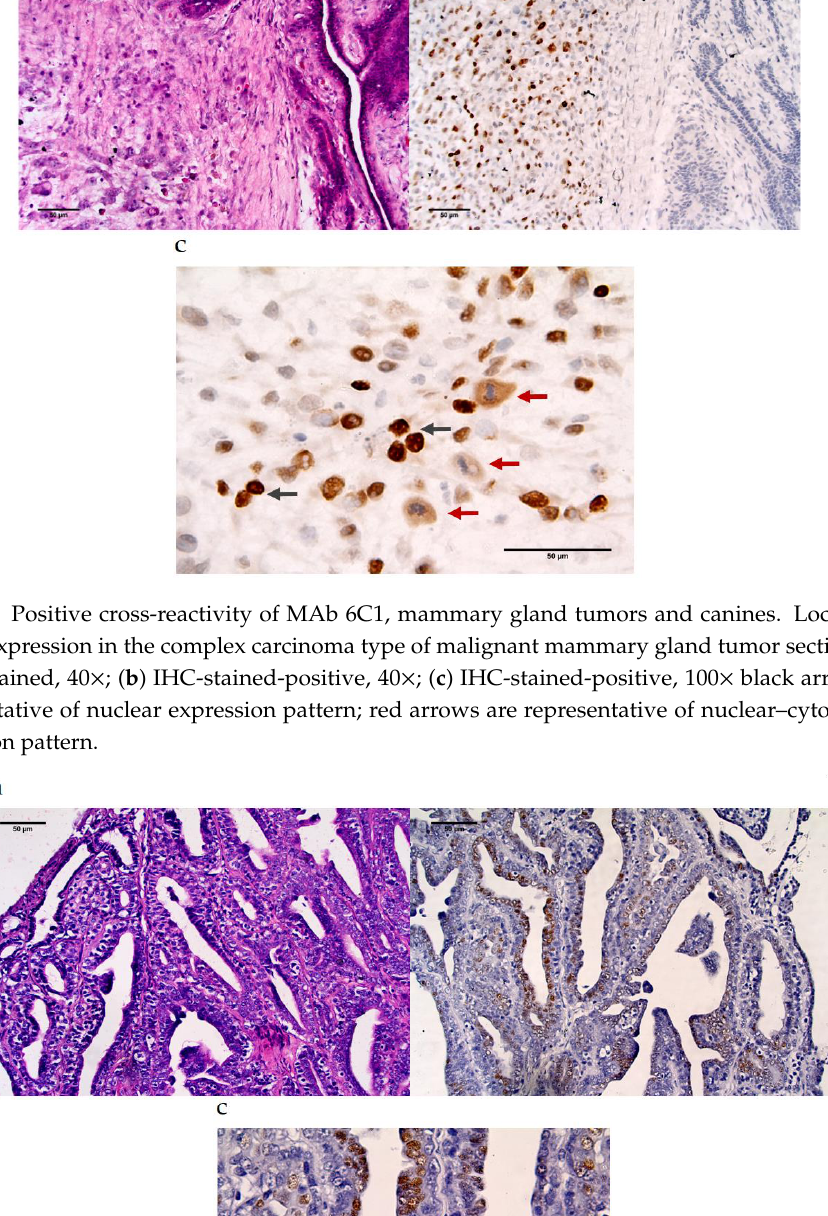
Figure 5 . Positive cross - reactivity of MAb 6C1, testis, mammary gland tumors and canines . Western blot analysis of testicular and CMT cells with human anti - MAGE Mab 6C1 . Black arrows indicate the